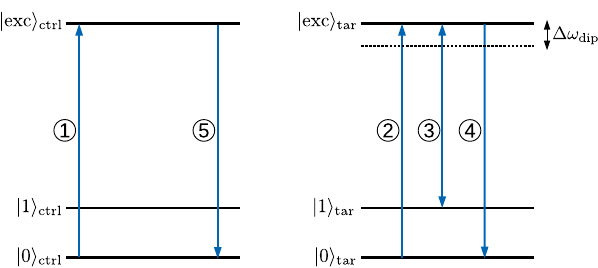
FIG. 6. Pulse sequence for the dipole-blockade scheme. If the control qubit is in state | 0 (cid:5) , it is excited, which shifts the levels of the target qubit out of resonance with the swapping pulses. A swap is thus only carried out if the control qubit is in state | 1 (cid:5) . The indices “ctrl” and “tar” denote the control and target qubits, respectively.